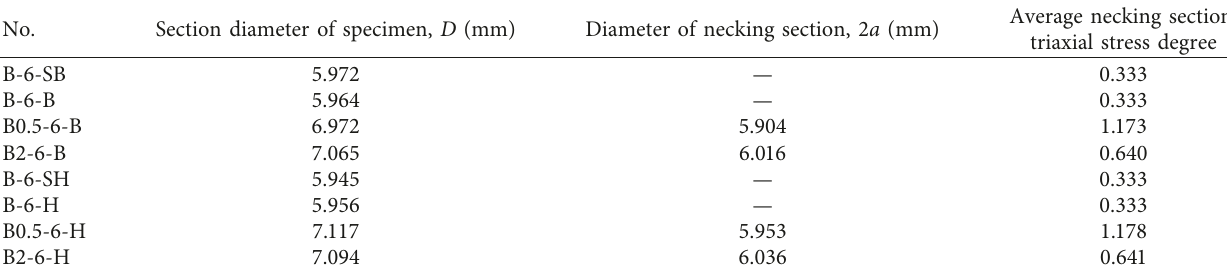
Table 2: Measurement data of round bar specimens.